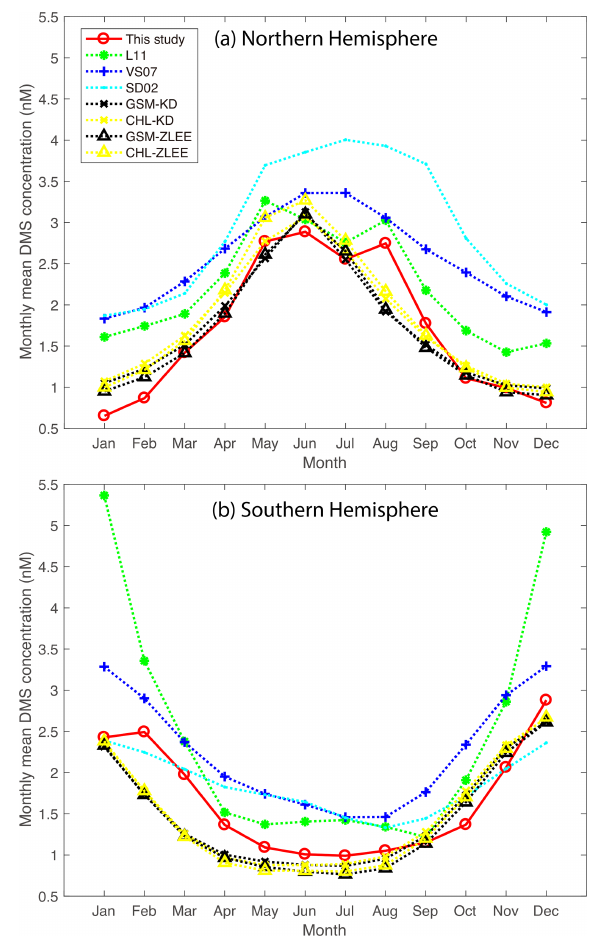
Figure 3. Comparisons of monthly mean DMS concentrations to previous studies (Simó and Dachs, 2002; Vallina and Simó, 2007; Lana et al., 2011; Galí et al., 2018). L11, SD02, and VS07 are self- explanatory. GSM-KD, CHL-KD, GSM-ZLEE, and CHL-ZLEE are the four model results from Galí et al.